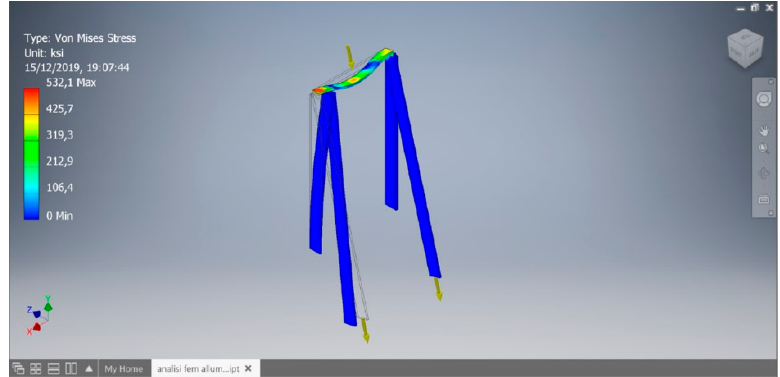
Figure 25. Messa a punto (MAP) stress analysis.